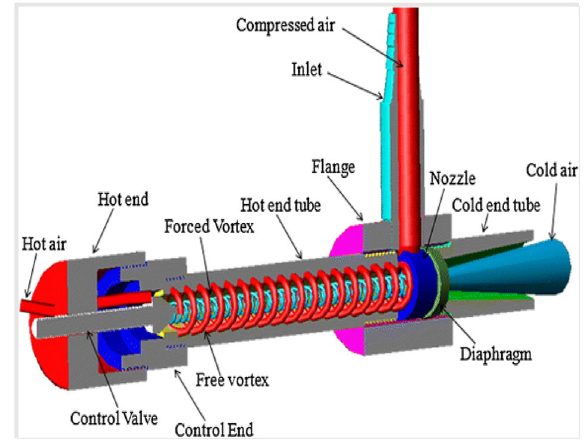
Figure 1. Vortex tube sectional view.